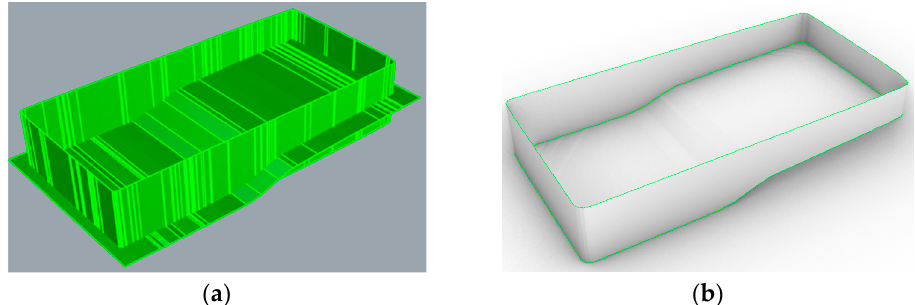
Figure 10. ( a ) Primitives representing the walls and bottom of the pool; ( b ) final 3D model of the pool.